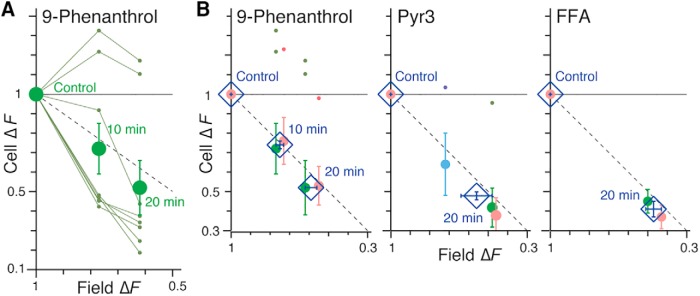
Effects of TRPM4, TRPC3, and ICAN channel inhibitors on inspiratory Ca2+ activity of the pre-BötC field and glutamatergic neurons expressing GCaMP6f. A, Example of relationship between normalized pre-BötC peak field GCaMP6f ΔF and normalized individual inspiratory cell ΔF, 10 and 20 min after bath-applied 50 µm 9-phenanthrol. Eight neurons (shown in Fig. 9) were tracked through time (connected green dots) within the two-photon optical section using automated ROI detection. Group mean values ± SEM of the normalized fluorescence transients are plotted (green filled circles with error bars) and the identity line (dashed) is indicated. Note that two of the neurons showed augmented fluorescence transients in this example, but the mean group cellular ΔF nevertheless followed the field ΔF. B, Group summary of effects of TRPM4, TRPC3, and ICAN inhibitors on the inspiratory pre-BötC field ΔF and cellular ΔF. Left: mean values of cellular ΔF (red, n = 6 neurons; green, n = 8, same as A) ± SEM during control period, 10 min, and 20 min after bath-applied 9-phenanthrol from two slices are indicated (diamonds and error crosses). Inspiratory neurons with unaffected or increased ΔF amplitude included in the group statistics are plotted individually at the top. Middle: three-experiment summary for Pyr3 (red, n = 6 neurons; green, n = 13; blue, n = 4). Right: two-experiment summary for FFA (red, n = 12 neurons; green, n = 6). Identity line (dashed) is indicated.